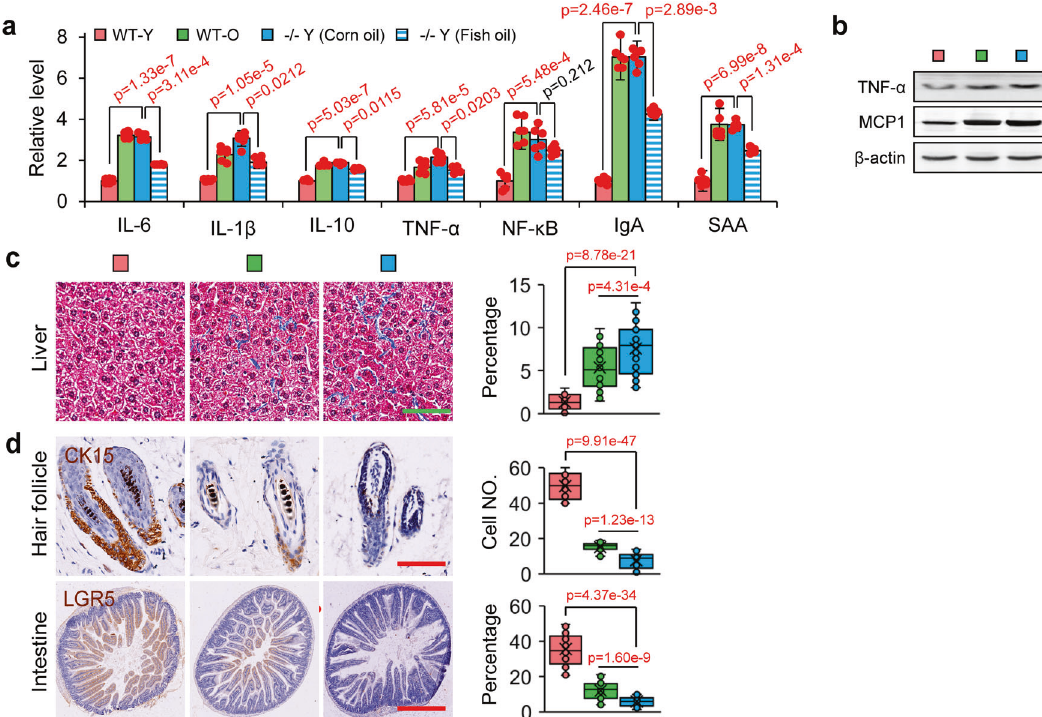
Fig. 4 Depletion of Elovl2 led to chronic in fl ammation, cellular senescence and adult stem cell exhaustion. a In fl ammatory factors levels in blood measured by ELISA ( n = 6 per group). Error bars, SEM. Levels of signi fi cance were calculated with two-tailed Student ’ s t test. b Western blotting of TNF- α and MCP-1 ( n = 3). c Masson ’ s trichrome staining on liver. Error bars, SEM. Scale bar, 100 µm. For each group 40 slices from fi ve mice were sed for statistical analysis. Levels of signi fi cance were calculated with two-tailed Student ’ s t test. d Hair follicles and intestines stained with the epithelial progenitor cell markers. Scale bar, 100 µm. Error bars, SEM. For each group 40 slices from fi ve mice were sed for statistical analysis. Levels of signi fi cance were calculated with two-tailed Student ’ s t